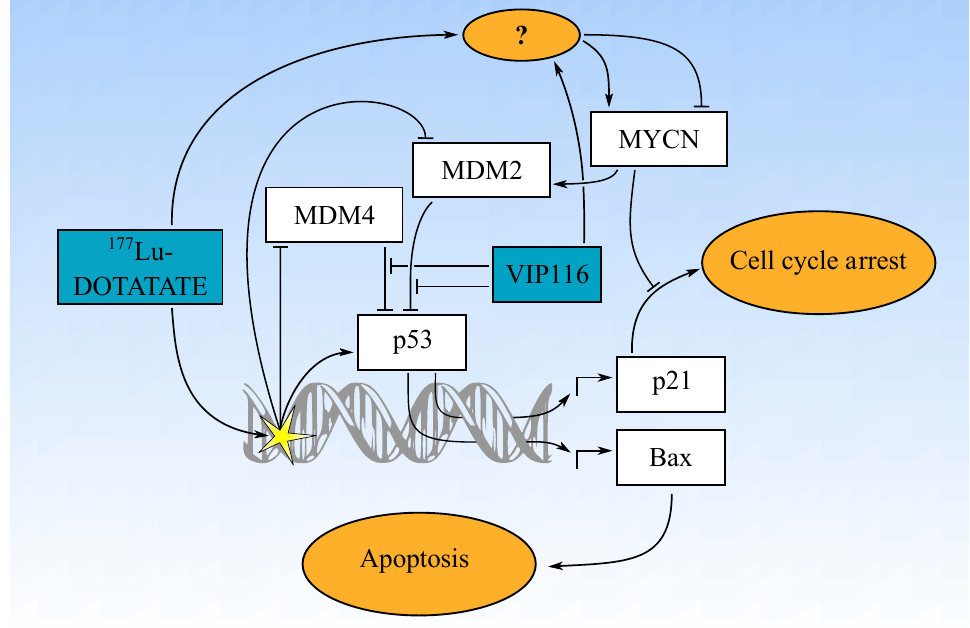
Figure 5. Suggested mechanism of VIP116-mediated potentiation of 177 Lu-DOTATATE in neuroblastoma. 177 Lu-DOTATATE causes DNA double strand breaks which initiates a slight p53-mediated response. VIP116 is able to enhance the p53 response and induce transcription of downstream targets, leading to increased apoptosis. MYCN, which can be induced or repressed by the therapies via unknown mechanisms, can affect p53 function negatively via MDM2 transcription or blocking p21-mediated cell cycle arrest.